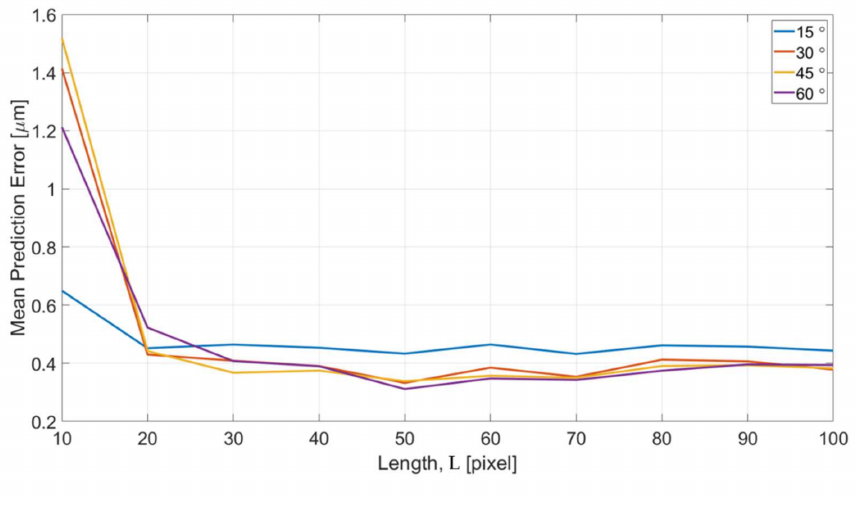
Figure 16. Effects of different feature length